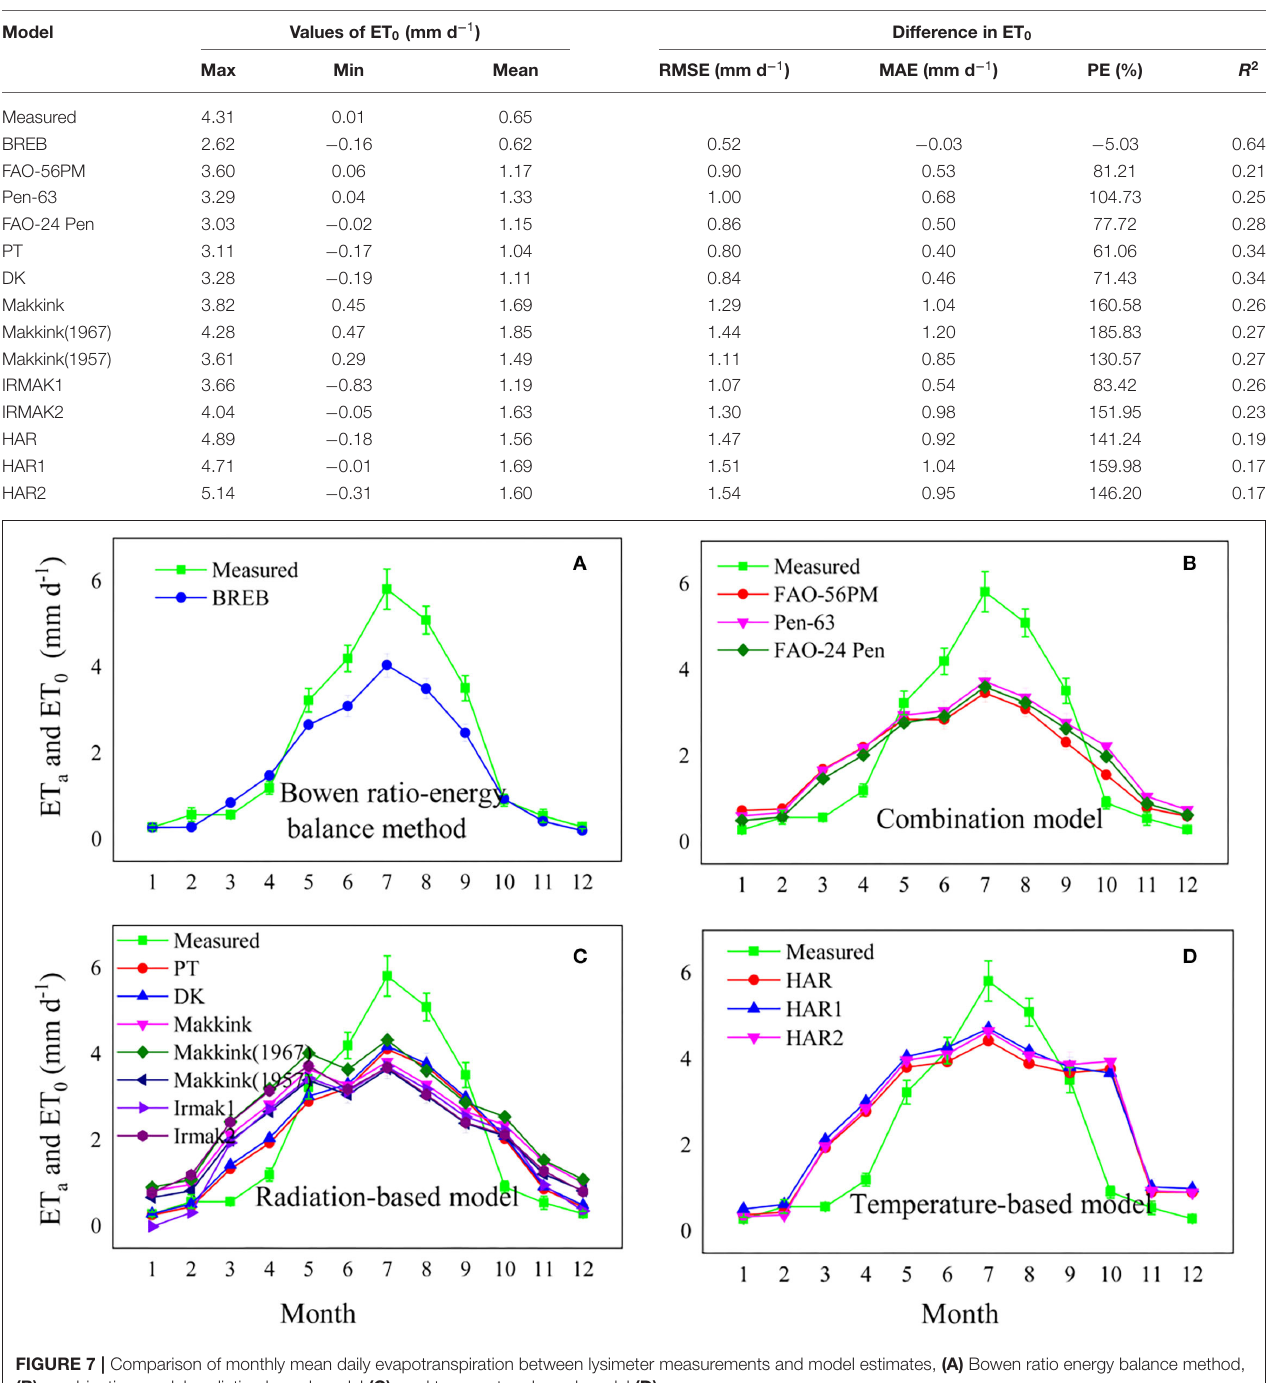
TABLE 5 | Summary of statistics for daily ET 0 between lysimeter measurements and model estimates during the nongrowing season (data points = 204). Model